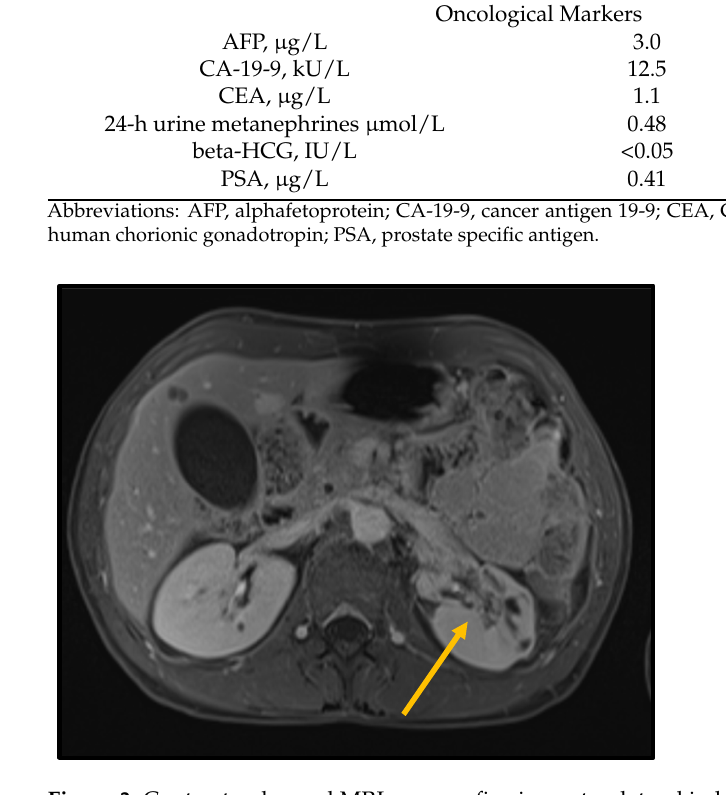
Figure 3. Contrast-enhanced MRI scan confirming anterolateral ischemic area involving especially renal medulla (orange arrow).